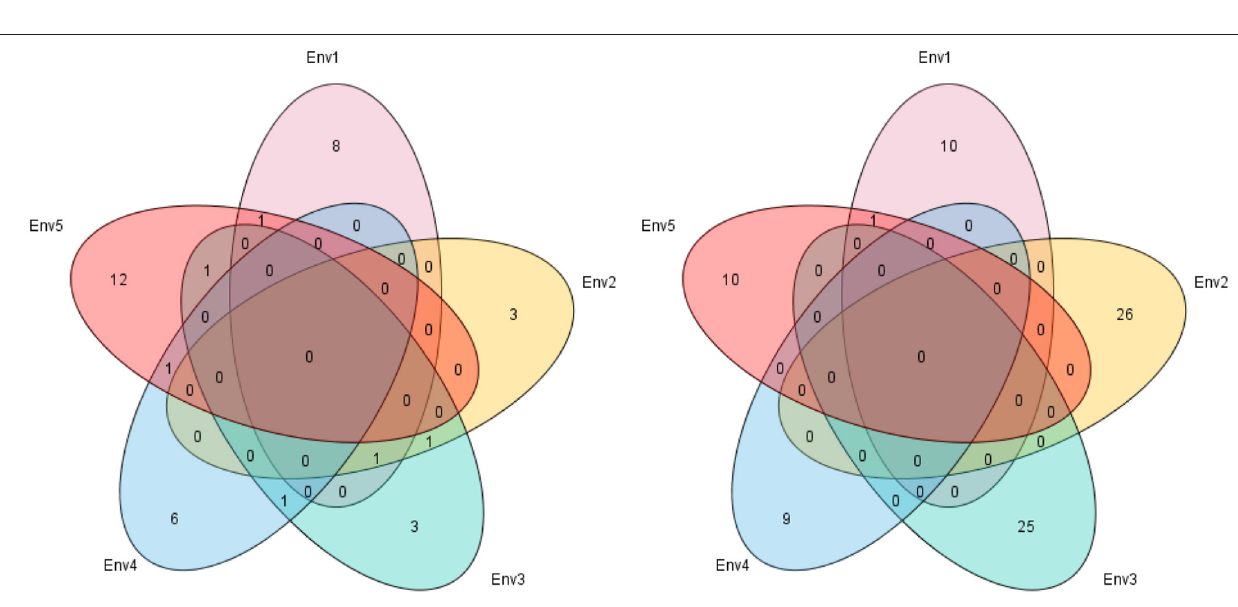
FIGURE 5 | Venn figure for frequency of linkage (left) and genome-wide association study (GWAS) (right) quantitative trail loci (QTL) underlying main stem node number (MSNN) in five environments. E1, Harbin in 2015; E2, Keshan in 2015; E3, Acheng in 2016; E4, Shuangcheng in 2016; E5, Harbin in